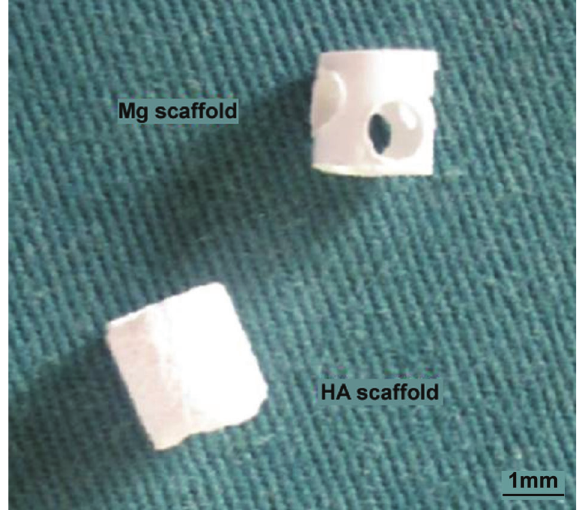
Figure 1. Example of the magnesium scaffold (top right) and hydroxyapatite scaffold (bottom